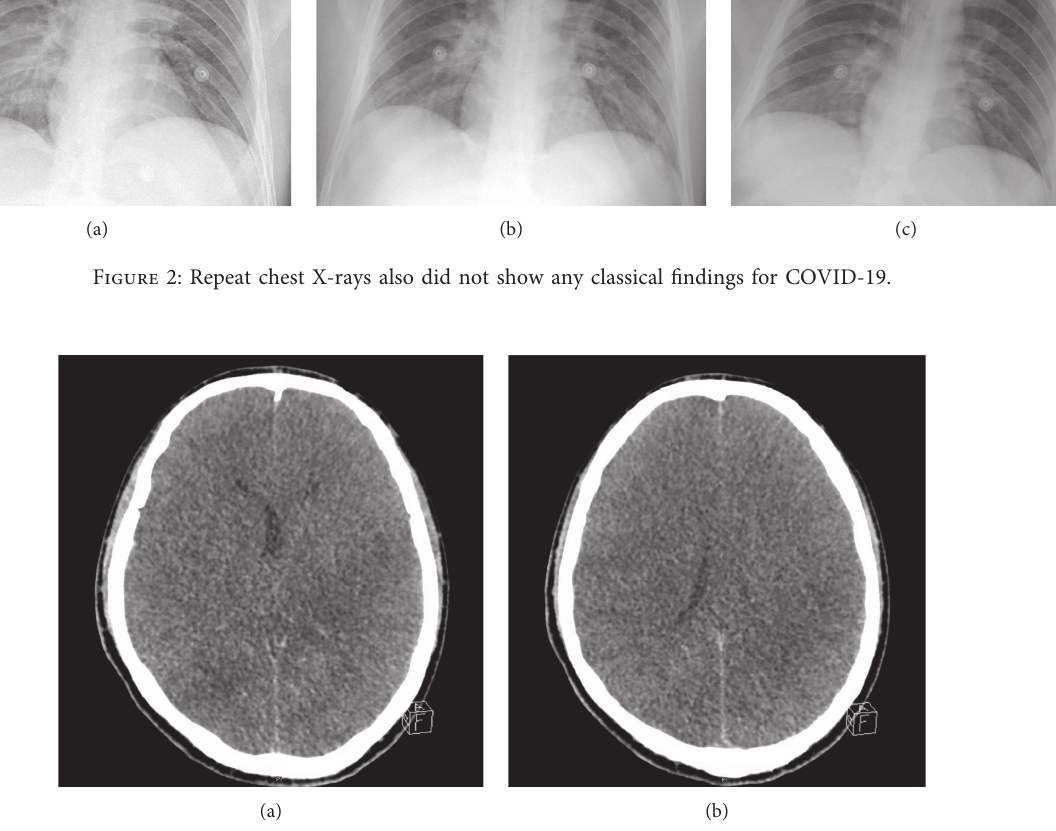
Figure 3: CT head slides showing brain edema on the 6 th day of admission.